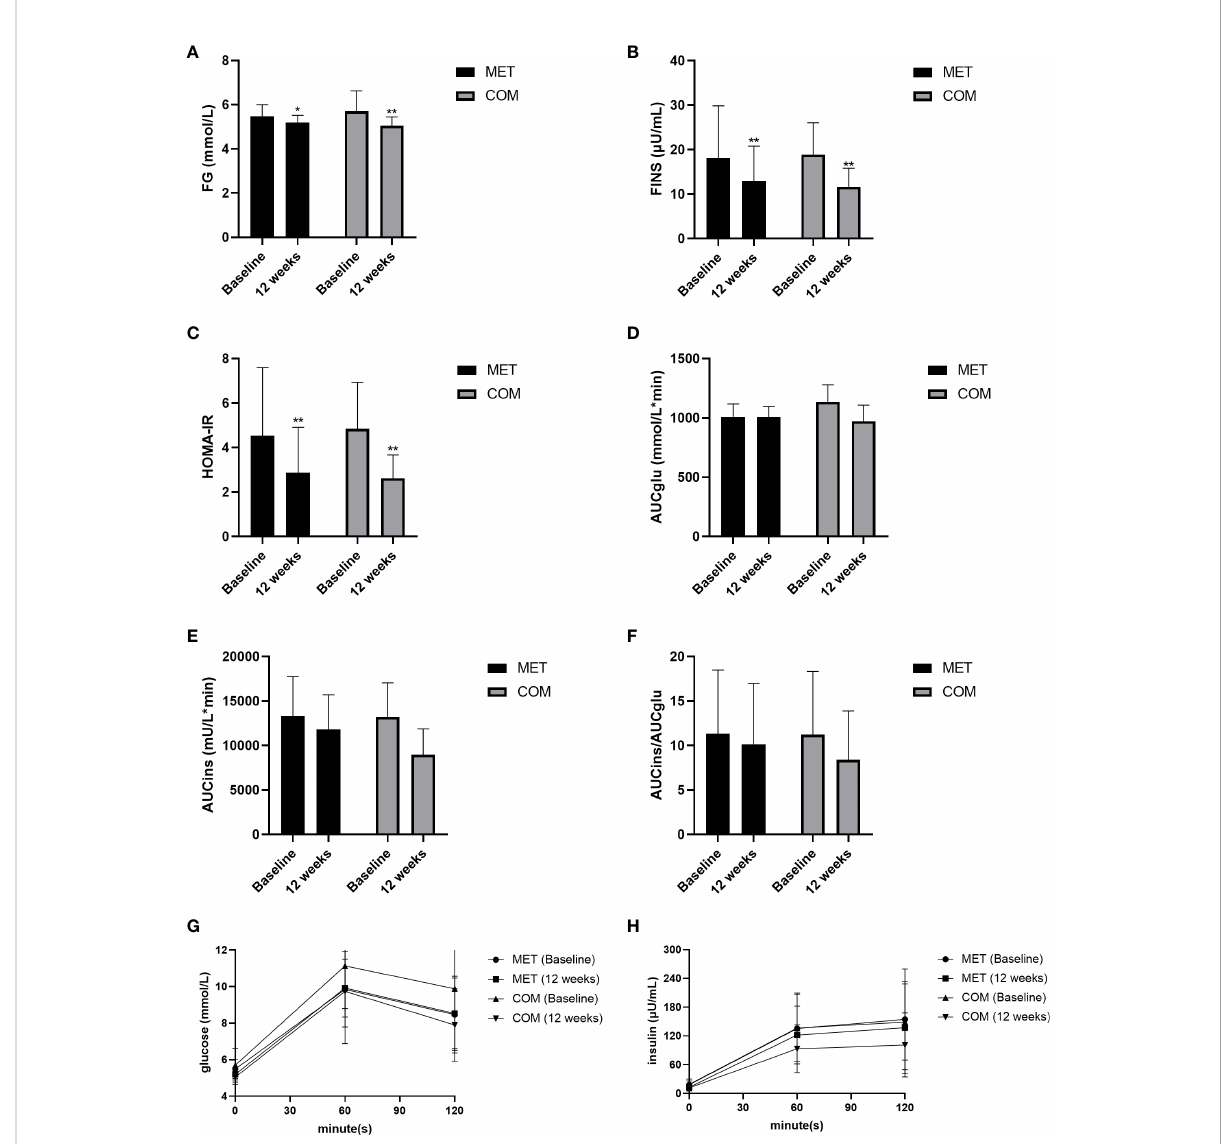
FIGURE 3 Changes in metabolic parameters after MET and COM therapy. (A) Changes in FG after MET and COM therapy. (B) Changes in FINS after MET and COM therapy. (C) Changes in HOMA-IR after MET and COM therapy. (D) Changes in AUCglu after MET and COM therapy. (E) Changes in AUCins after MET and COM therapy. (F) Changes in AUCglu/AUCins after MET and COM therapy. (G) Changes in OGTT (glucose) after MET and COM therapy. (H) Changes in OGTT (insulin) after MET and COM therapy. MET, metformin; COM, combine; FG, fasting glucose; FINS, fasting insulin; HOMA-IR, homeostasis model assessment-insulin resistance; AUCglu, area under the curve (AUC) for glucose; AUCins, AUC for insulin. Results are expressed as mean ± SD; * P < 0.05, ** P < 0.01 (vs. before treatment in each